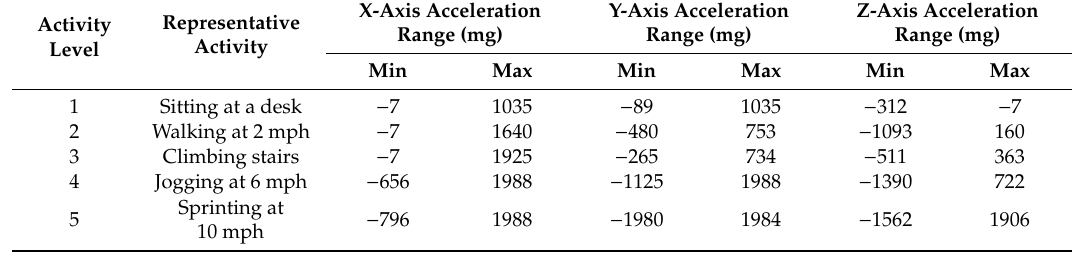
Table 1. An intensity scale was defined according to a set of representative activities. The acceleration ranges for each activity were used to di ff erentiate between activity levels.